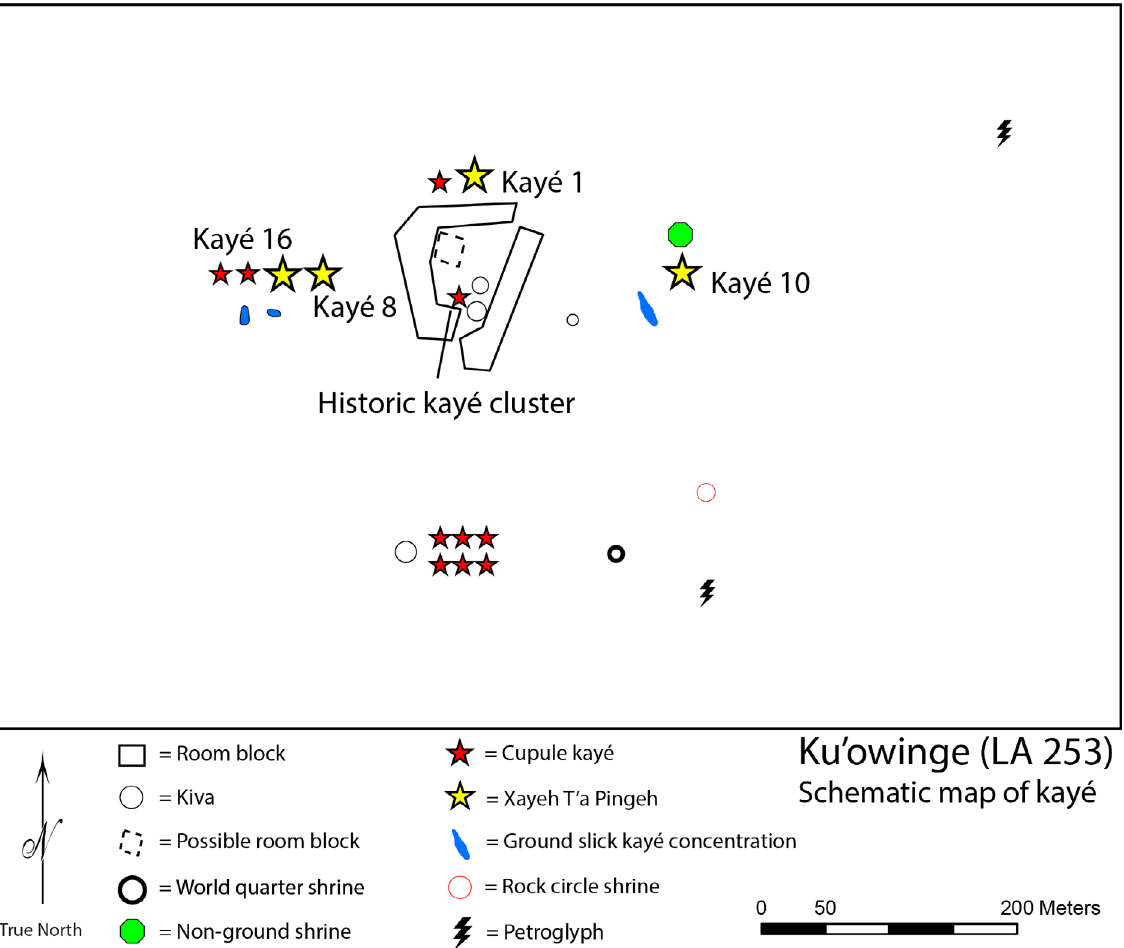
Figure 6. Kayé and Xayeh T’a Pingeh with cupules, and associated landscape features, at the Classic period site of Ku’owingeh. [NOTE (23 JUNE 2017): This figure has been modified at the request of the